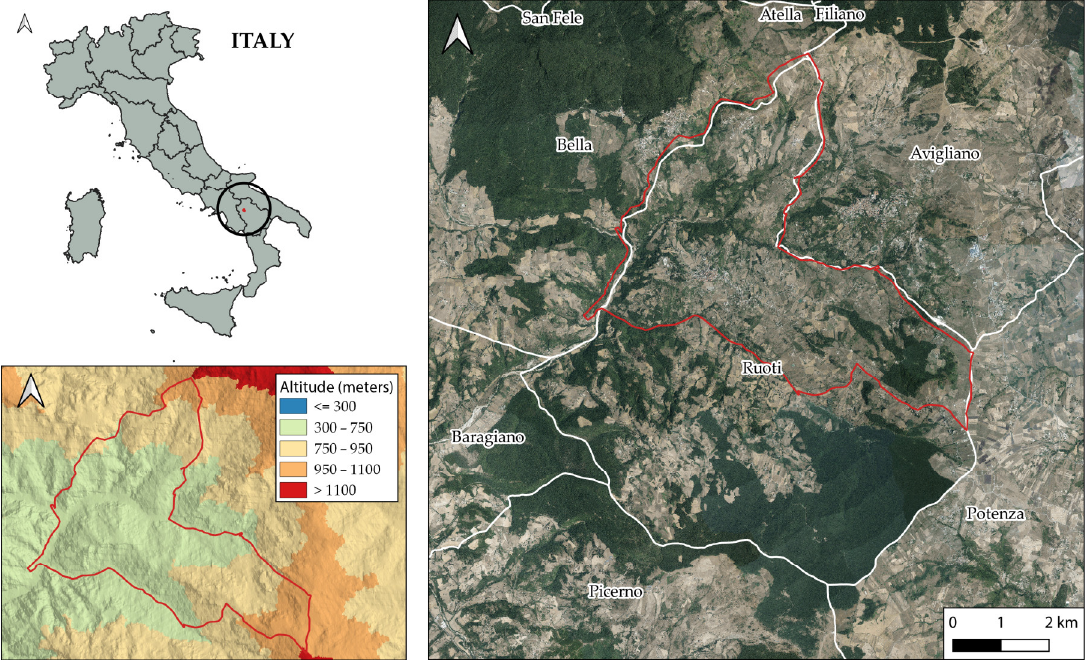
Figure 1. Geographical localization and altitude profile of the study area. The digital terrain model for the altitude map and the 2017 orthophotos have been downloaded from the geoportal of the Basilicata region under license IODL 2.0 [47].